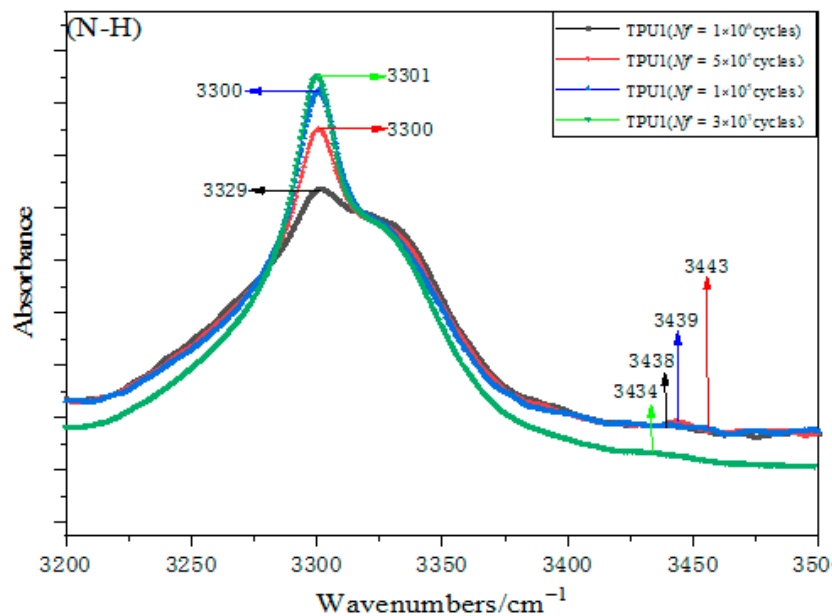
Figure 10. The change in NH stretching band ( ν (NH)) of TPU samples after fatigue.